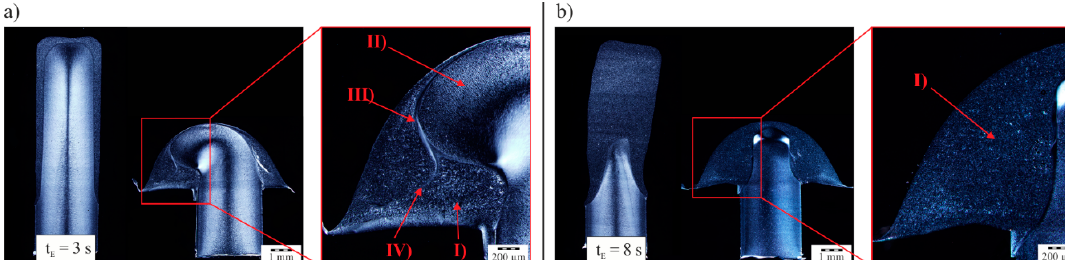
Figure 5. Heating and forming behavior characterized by the materials structure in the rivet pin and the rivet head, illustrated in ( a ) by the comparison of a short heating time (t E = 3 s) and in ( b ) by a long heating time (t E = 8 s)—( I ) melted and recrystallized structural zone, ( II ) cold formed structural zone, ( III ) shear zone during forming between melted and non-melted material, ( IV ) weld line. Process parameters: material PP, diameter rivet pin d P = 3.0 mm, air temperature T A = 300 °C, air flow rate Q ̇ A = 75 L/min, heating time t E = 3 s/8 s, joining force F J = 80 N, cooling time t C = 12 s.